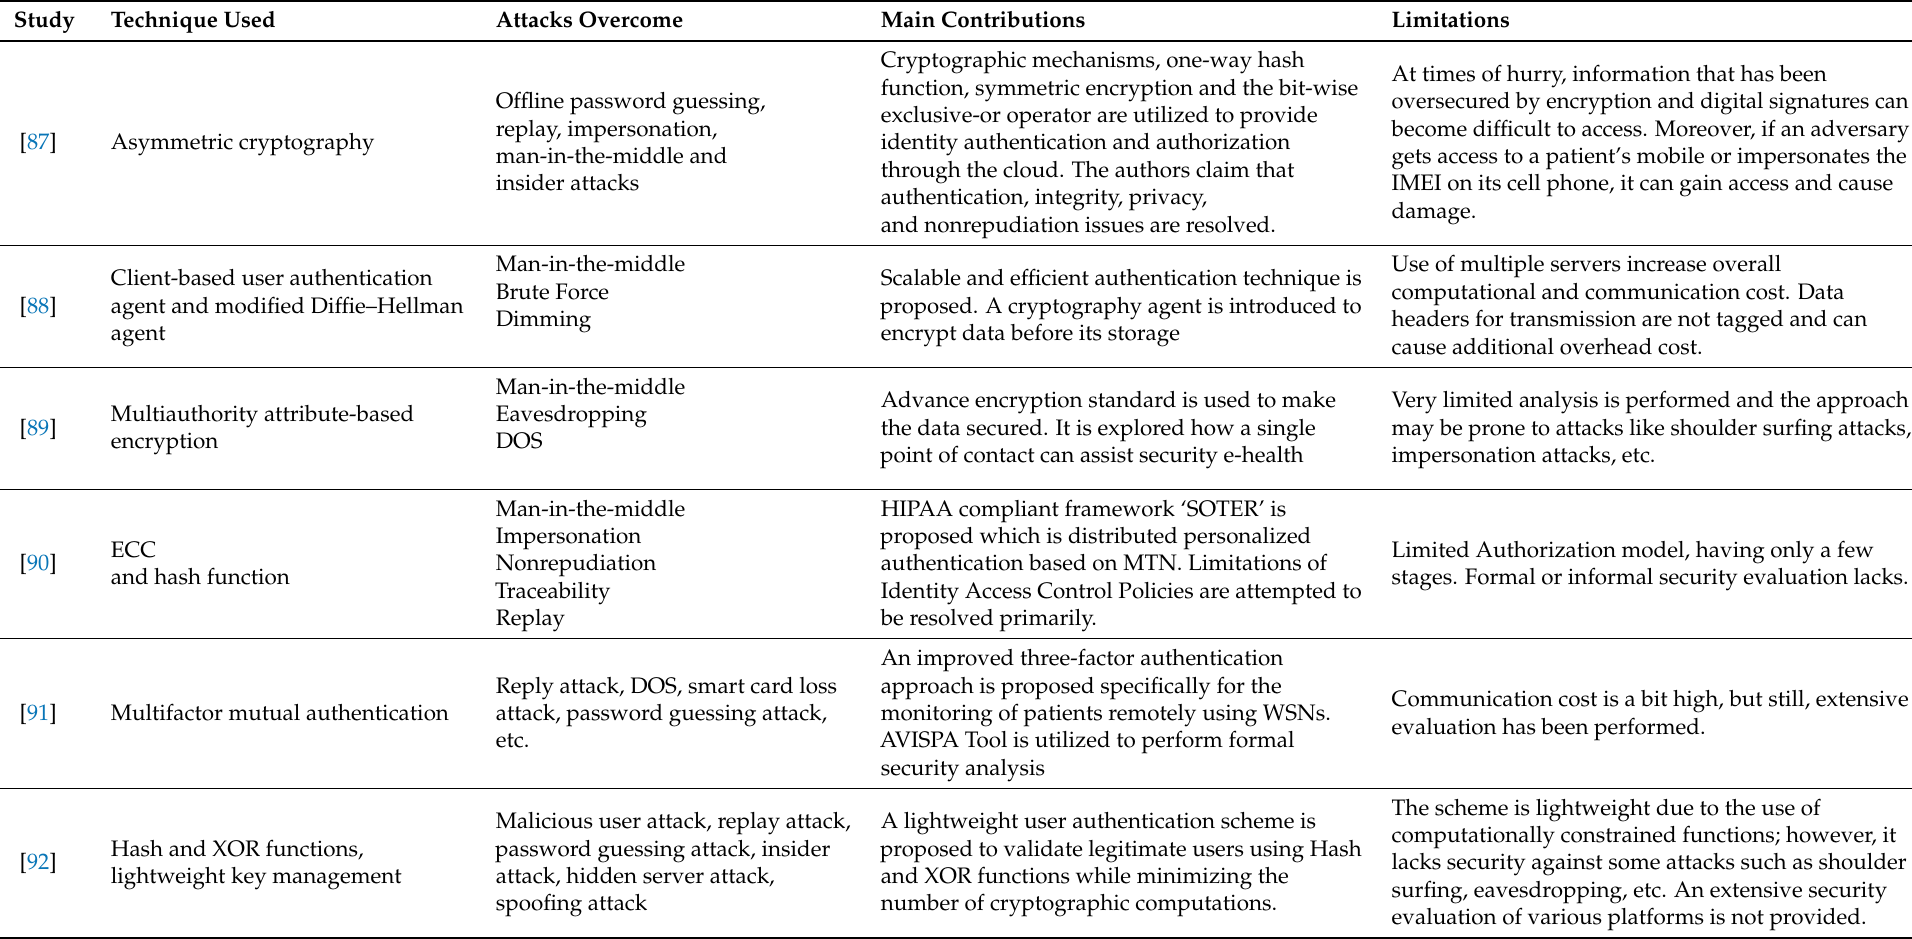
Table 2. Cloud-based authentication techniques in IoT-enabled healthcare